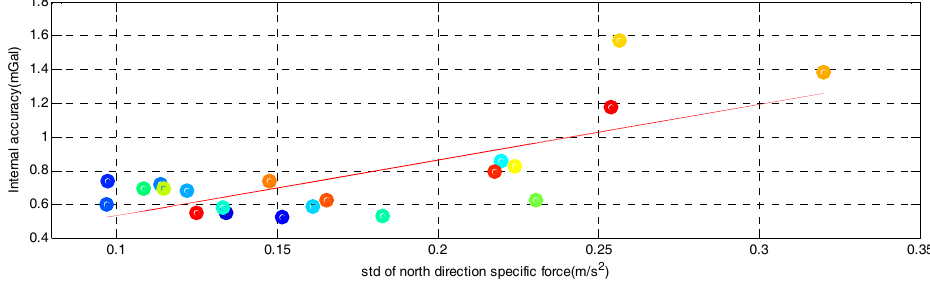
Figure 9. The relation between horizontal specific force and internal RMSE.